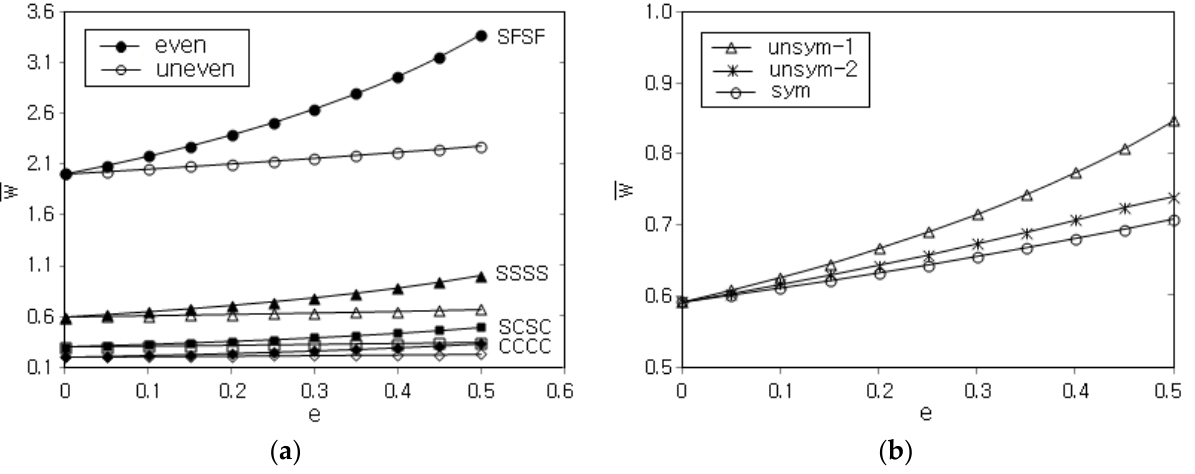
Figure 5. Dependence of the calibrated central deflection on the porosity parameter ( a / h = 20, n = 0.3 ): ( a ) for different boundary conditions, ( b ) for different cosine-type porosity dis-